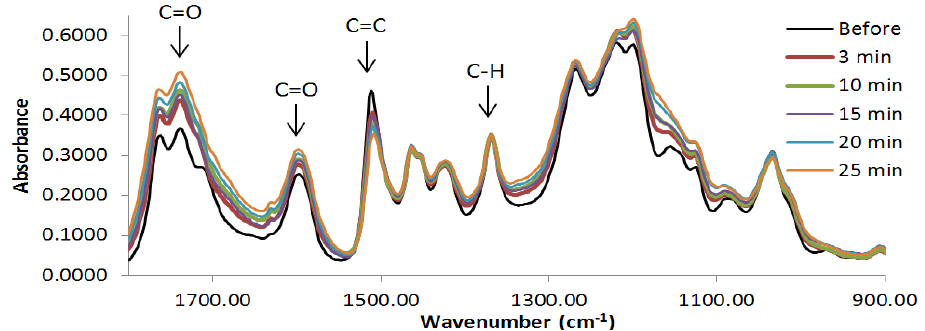
Figure 1. FTIR spectra of acetylated softwood kraft lignin (Ace-SKL) after different durations of UV